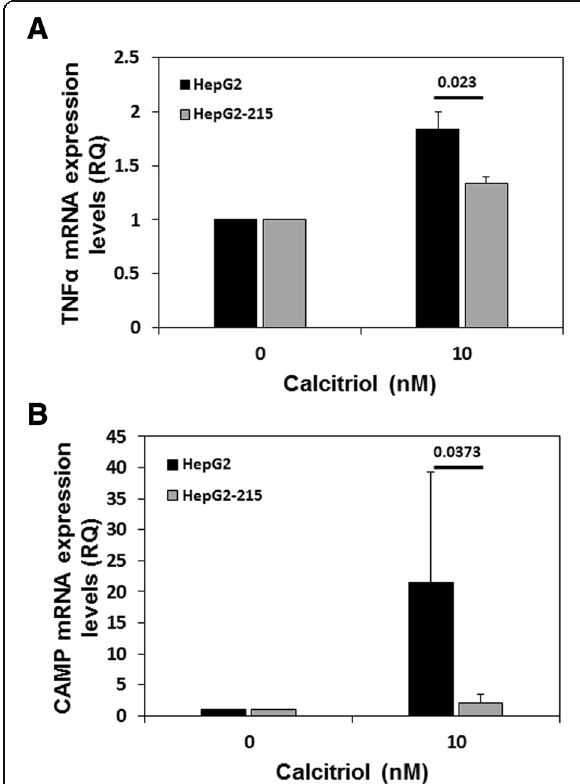
Fig. 5 TNF α and CAMP expression levels were significantly lower in Calcitriol-treated HepG2 HepG2.2.15 as compared with HepG2 cells. HepG2.2.15 and HepG2 cells were treated with 10 nM Calcitriol or EtOH, as a control. 24 h later, the cells were harvested and TNF α ( a ) and CAMP ( b ) levels were measured by RT-PCR. ( p = 0.023 and p = 0.0373, respectively). Results are expressed as